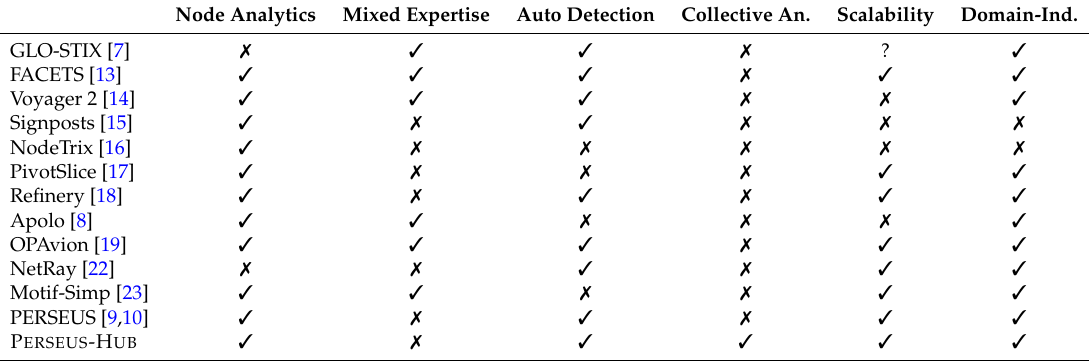
Table 1. Qualitative comparison of P ERSEUS -H UB with alternative approaches. (i) Node analytics: Does the visualization framework provide node-specific statistics or analytics? (ii) Mixed Expertise: Can the visualization tool be used by users with varying levels of expertise (e.g., experts, beginners or users with limited familiarity with the graph data)? (iii) Automatic Pattern Detection: Does the visualization tool automatically detect specific patterns and guide users to them? (iv) Collective Analysis: Does the visualization tool support information sharing among users? (v) Scalability: Can users analyze large-scale, real-world graphs with the tool? (vi) Domain-independence: Does the